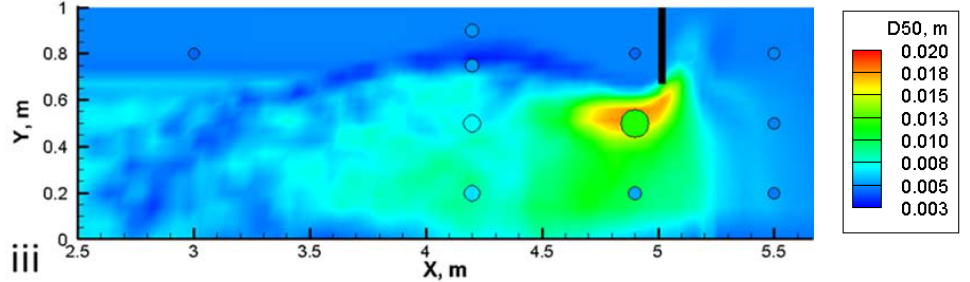
Figure 10. Measured (circles) and calculated (i: vR; ii: Wilcock and Crowe formula; iii: combined approach) d 50 distribution at Q = 58 L/s.